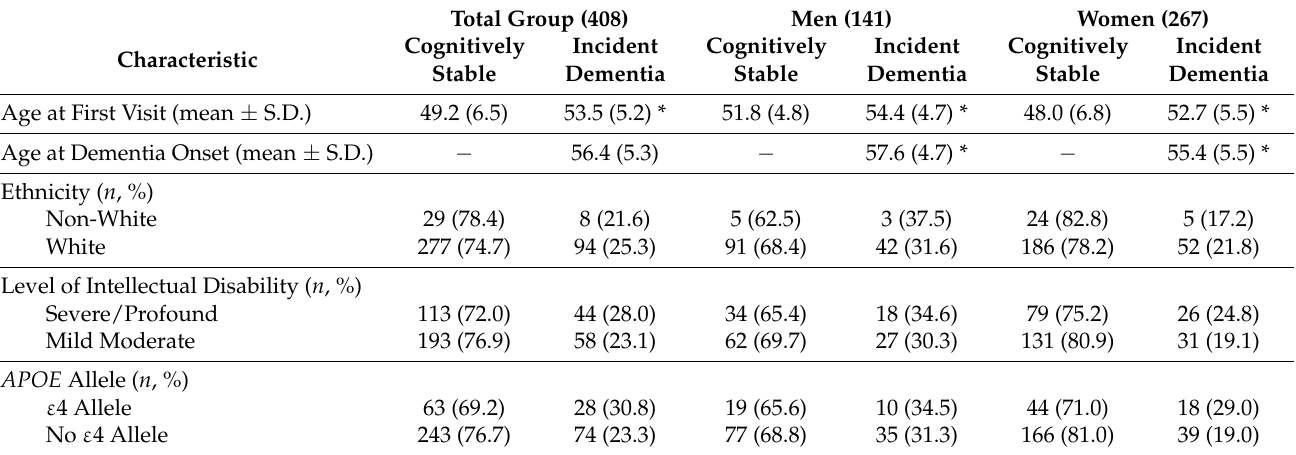
Table 1. Demographic characteristics by sex and AD dementia status. Total Group